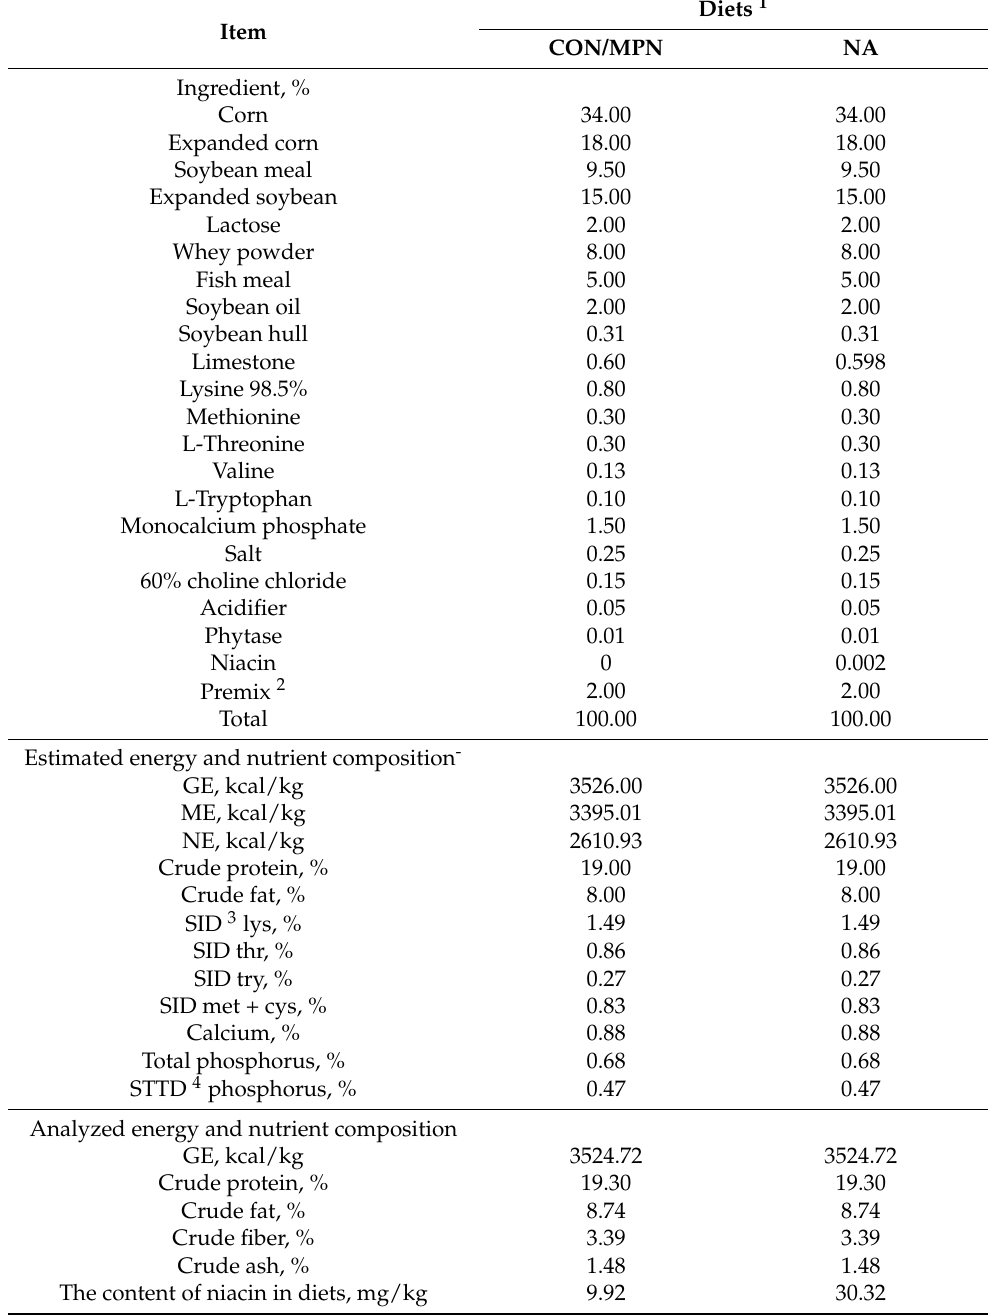
Table 1. Formulation and chemical composition of the basal diet (on an 88.53% dry matter